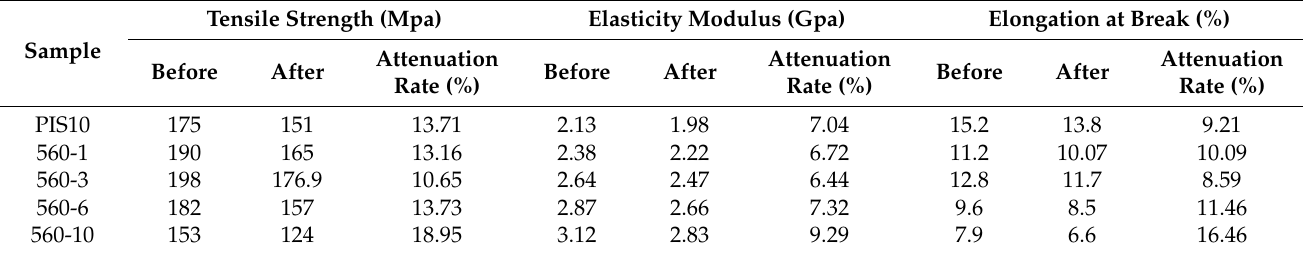
Table 1. The mechanical properties of PI/SiO 2 films before and after